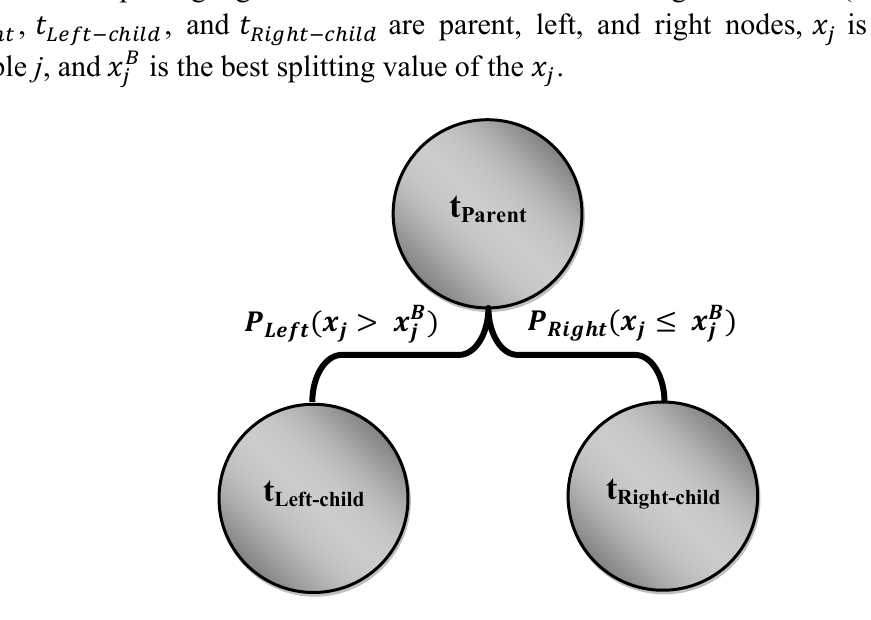
is the splitting (cid:3037)